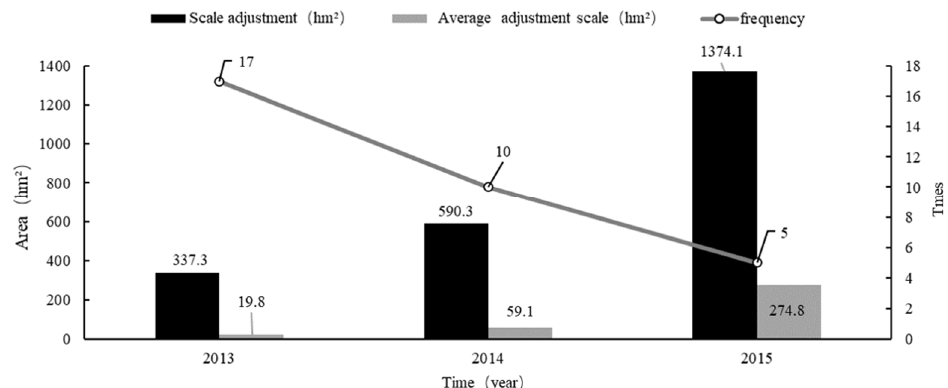
Figure 4. Planning adjustment in Rongchang District from 2013 to 2015.